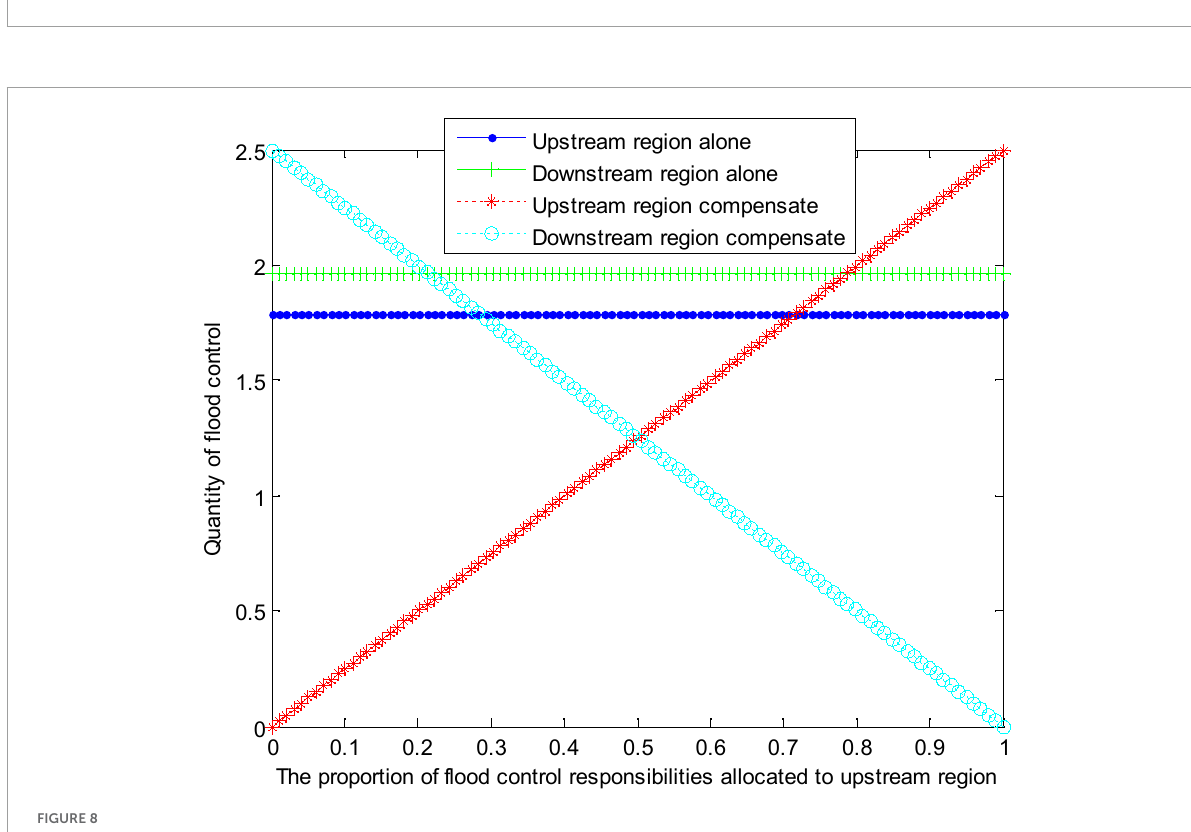
FIGURE7 The impact of compensation on flood control.